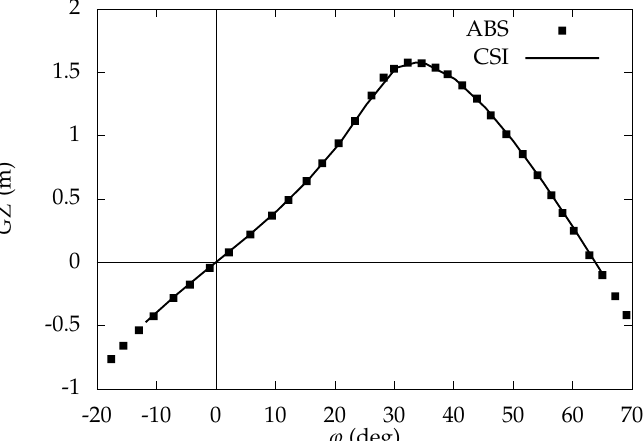
Figure 16. GZ curve for barge test case for the assessment of dead ship level 1. Table 5. Level 1 assessment of dead ship failure mode for barge.